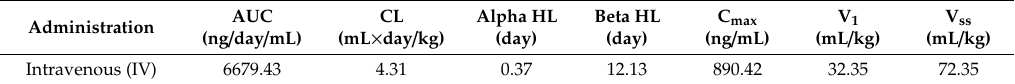
Figure 5. Pharmacokinetic profile of acDrug after intravenous administration of 3 mg / kg LCB14-0110 ADC in rats. Table 4. Pharmacokinetic parameters of acDrug after intravenous (IV) administration of 3 mg / kg LCB14-0110 in rats.